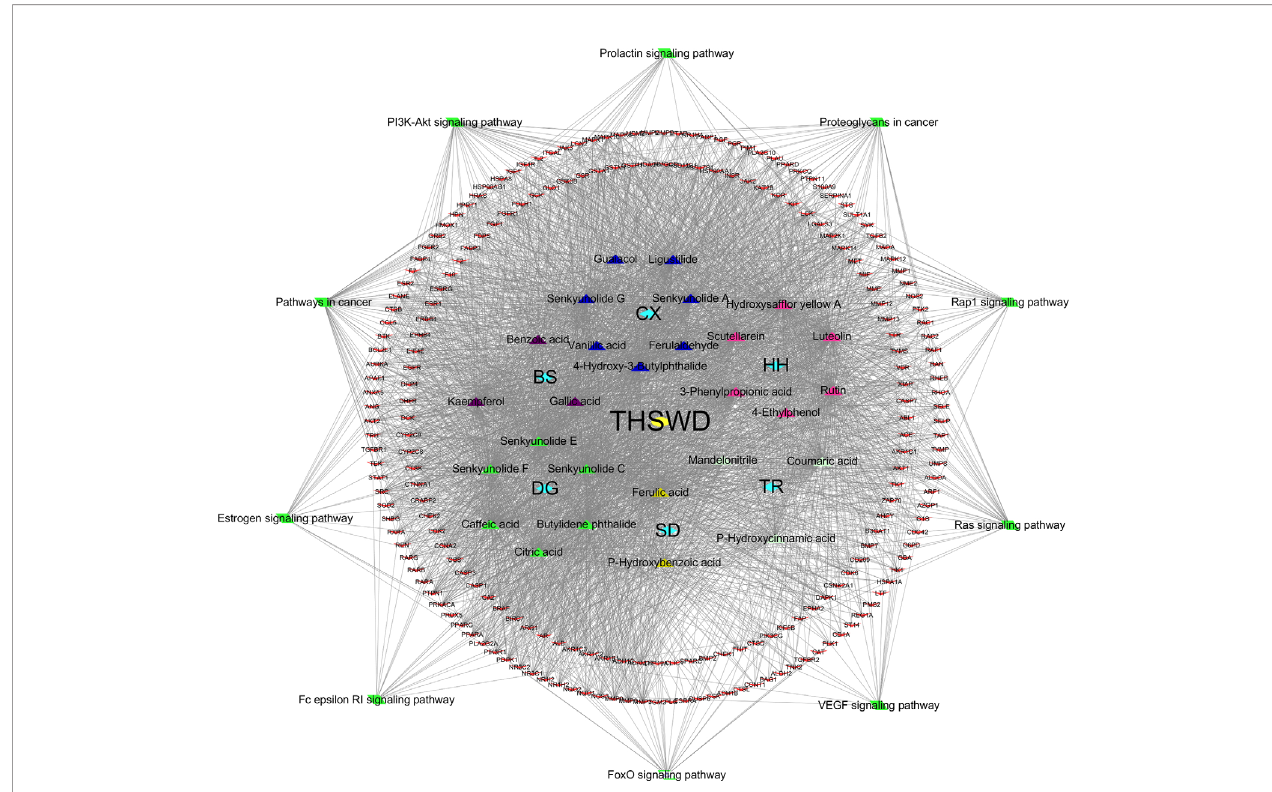
FIGURE 7 | “ THSWD-prescription composition-active ingredients-targets-pathways ” . The yellow diamond represent THSWD, the cyan diamond represent medicinal herbs, the triangle represent the components, the red v-shaped represent the intersection targets, and the green diamond represent the signal paths.